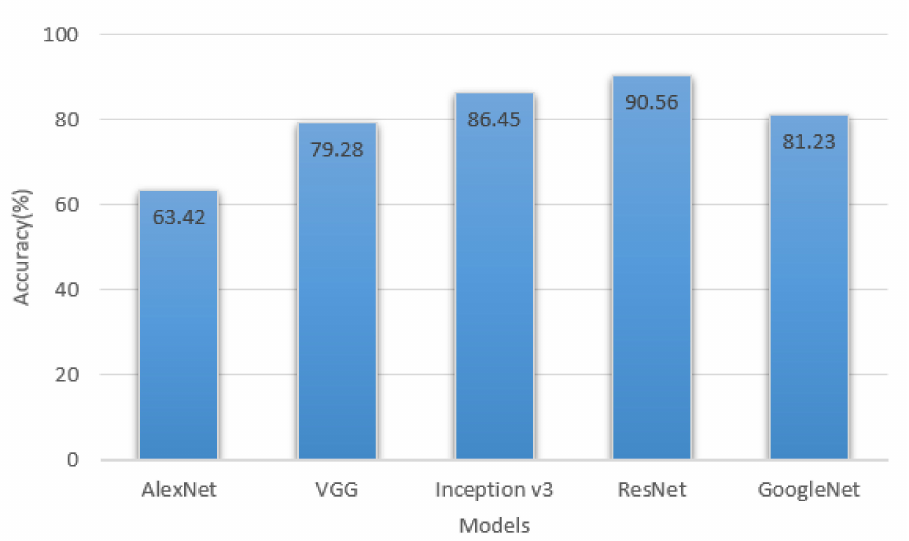
Figure 4. Accuracy performance of each CNN model on the test set.